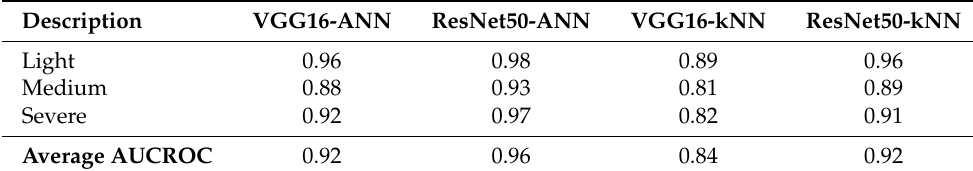
Table 6. Area under curve of ROC for each class based on greyscale